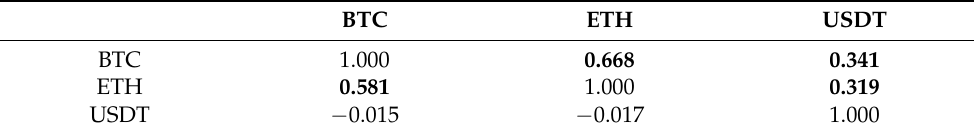
Table 2. Correlations between returns and squared returns.